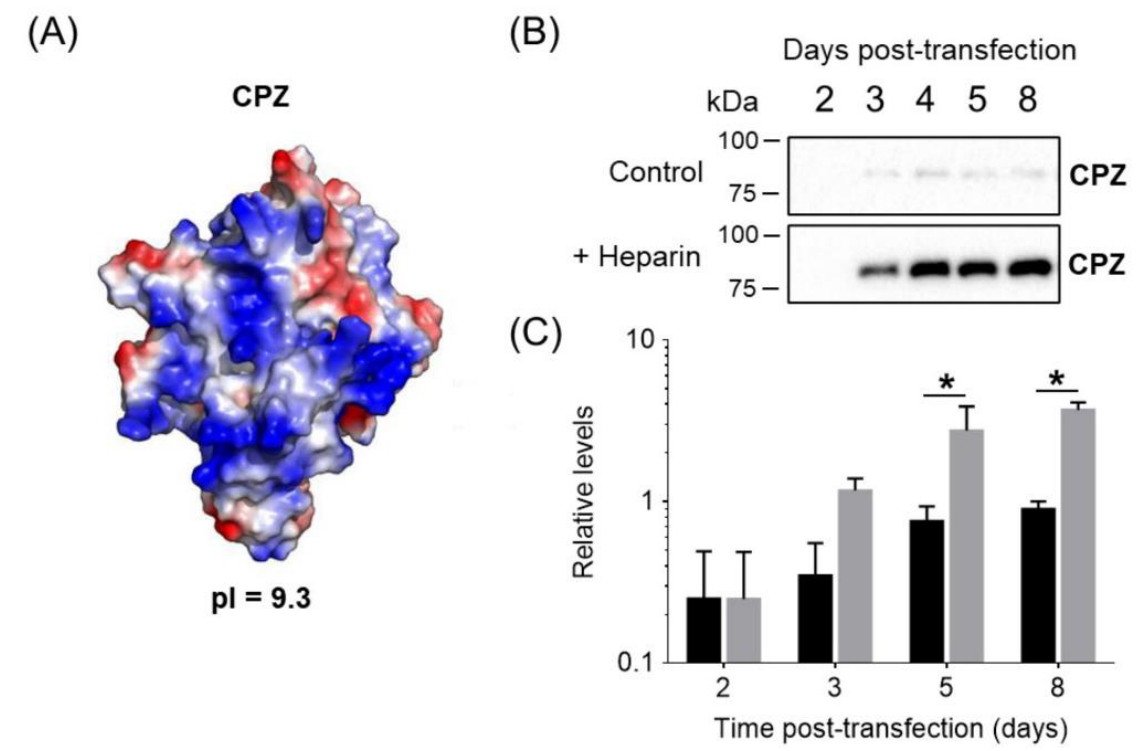
Figure 2. Enhanced expression of human CPZ in HEK 293F cells after heparin supplementation. ( A ) Electrostatic surface potential distribution of the catalytic domain of human CPZ (AlphaFold model AF-Q66K79-F1). Blue and red indicate positive and negative charge potential, respectively. The iso- electric point (pI) of the full-length CPZ is indicated. ( B ) Representative immunoblots of the human CPZ expression over time in HEK 293F cells in the absence (black bars) and presence (grey bars) of heparin as additive (50 IU/mL). CPZ levels were determined using an anti-Strep-tag antibody. ( C ) Representative relative expression levels of human CPZ over time in HEK 293F cells. Values were normalized to the maximum CPZ signal detected in the conditioned medium in absence of heparin. Values are mean ± SEM of 3 independent experiments. Two-way ANOVA was performed, followed by Sidak’s multiple comparison test, which was limited to comparing the mean protein levels in the presence and absence of heparin for the different time points. The two-way ANOVA suggested that CPZ expression levels depended both on the presence/absence of heparin and the days of expres- sion. The asterisk represents a significant difference in means between absence and presence of hep- arin when an α of 0.05 is considered .